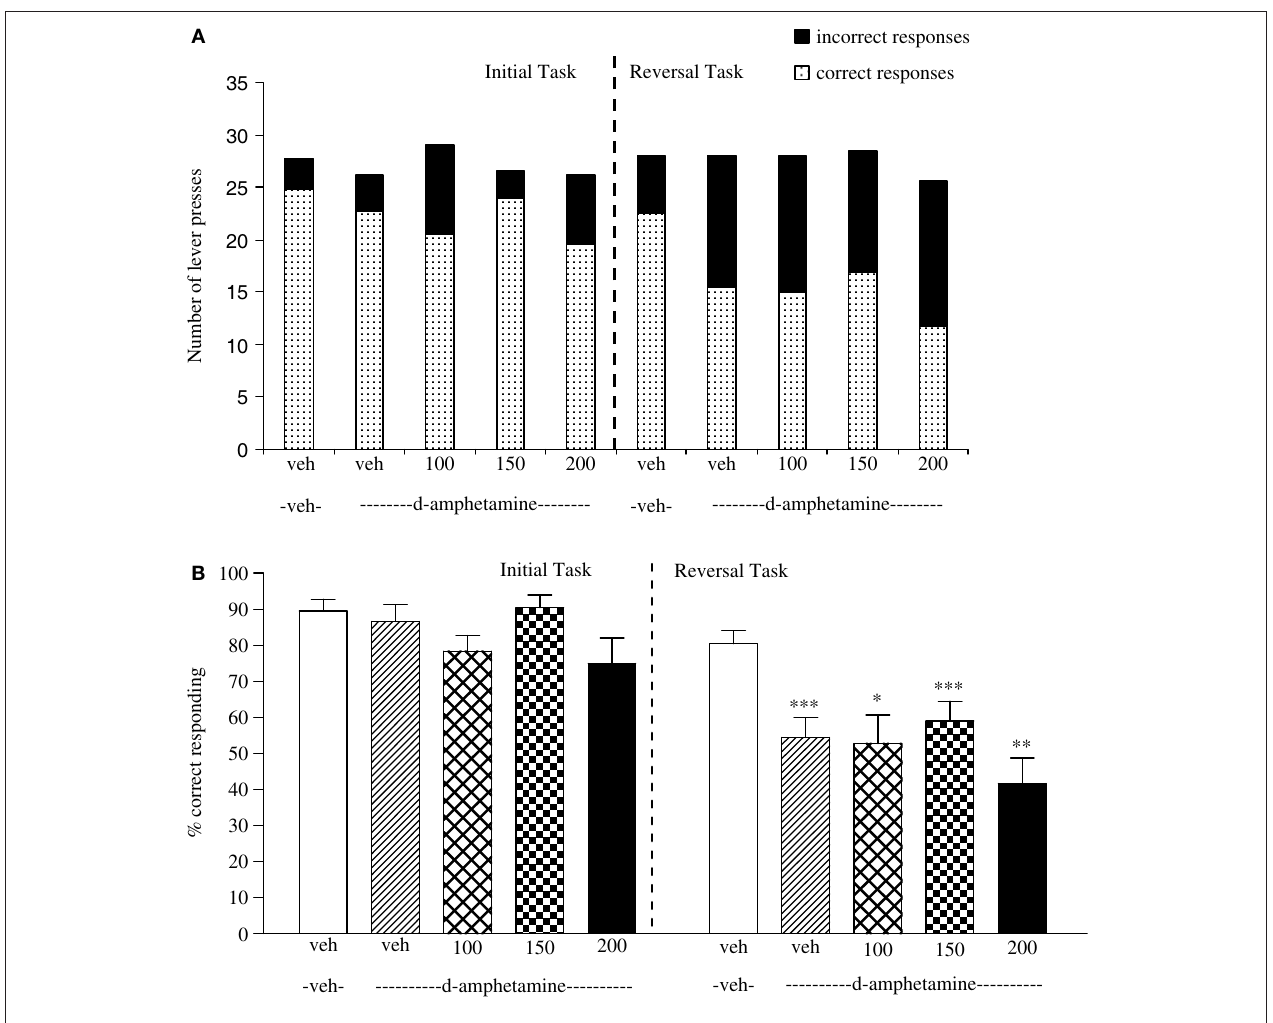
defi cit produced by D -amphetamine (0.5 mg/kg, i.p.) on performance of the reversal phase in a reversal learning task. Data are shown as mean ±